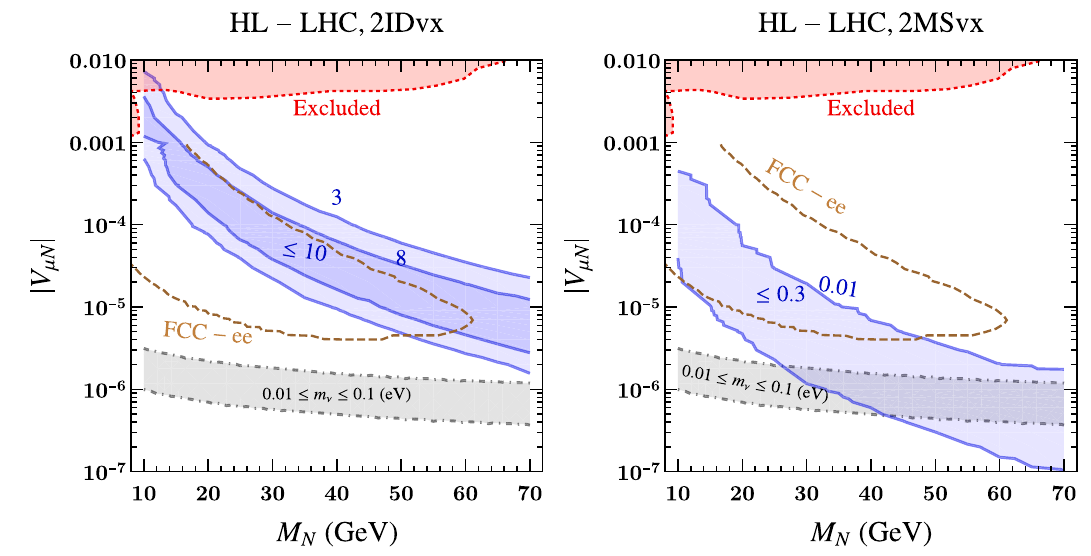
Fig. 11 Numberof2IDvx(left)and2MSvx(right)eventsasafunction browndashedlinerepresentstheFCC-eeprojection[69,70],andthered shaded region indicates current limits [71,72]. The grey band illustrates of the RHN mass M N and the active-sterile neutrino mixing strength | V μ | ,attheHL-LHCwith L = 3ab − 1 for M = 1TeV, g (cid:2) = 3 × 10 − 3 the range of | V μ N | required to generate light neutrino masses between N Z (cid:2) 0 . 01 eV and 0 . 1 eV through the seesaw mechanism, m ν = | V μ N | 2 M (solid blue lines and shaded regions). The value following the ≤ symbol indicates the approximate maximal number of events in each case. The